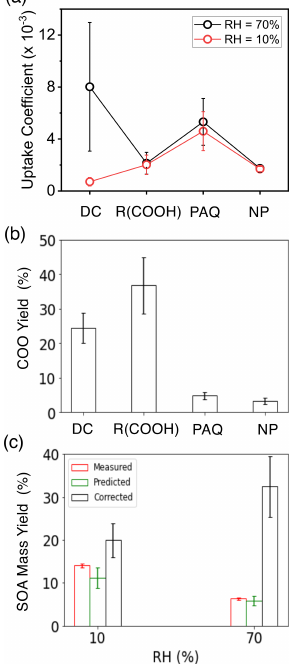
Figure 7. Uptake coefficient, COO yield, and SOA mass yield. (a) Average uptake coefficients ( γ ) for different types of COOs at 10% (red) and 70% (black) RH for (NH 4 ) 2 SO 4 seed particles with 19ppbNH 3 at 298K. (b) COO yields: dicarbonyls, organic acids, polyhydroxy aromatics/quinones, and nitrophenols are rep- resented by DC, R (COOH) n , PAQ, and NP, respectively. (c) SOA mass yields at 10% (left columns) and 70% RH (right). The red, green, and black columns represent the measured, predicted, and corrected (for wall loss) SOA mass yields according to Eqs. (19)– (22). All experiments are carried out for 14µgm − 3 (NH 4 ) 2 SO 4 seed particles with 19ppbNH 3 at 298K. The error bars denote the 1 σ of three replicated measurements or by accounting for er- ror propagation of the measured